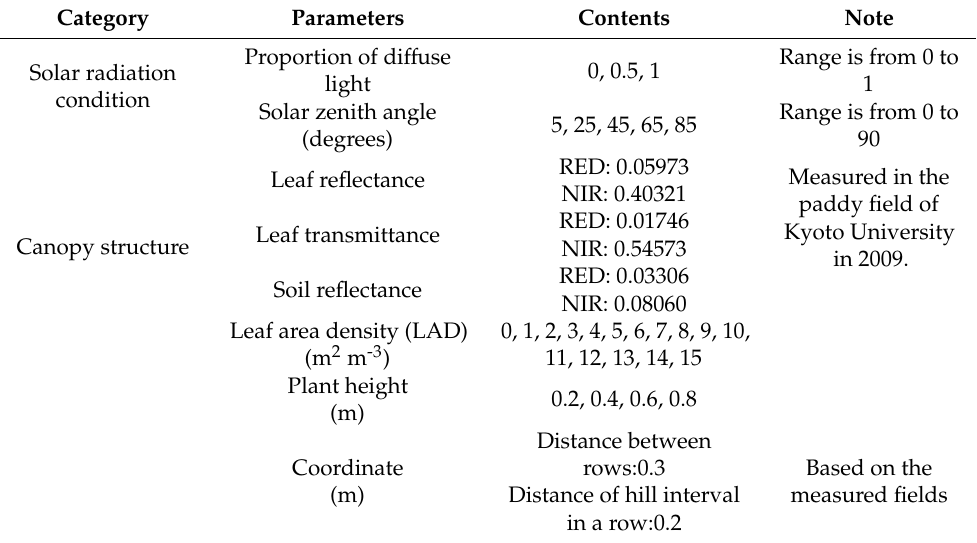
Table 1. Major Forest Light Environmental Simulator (FLiES) parameters set in this